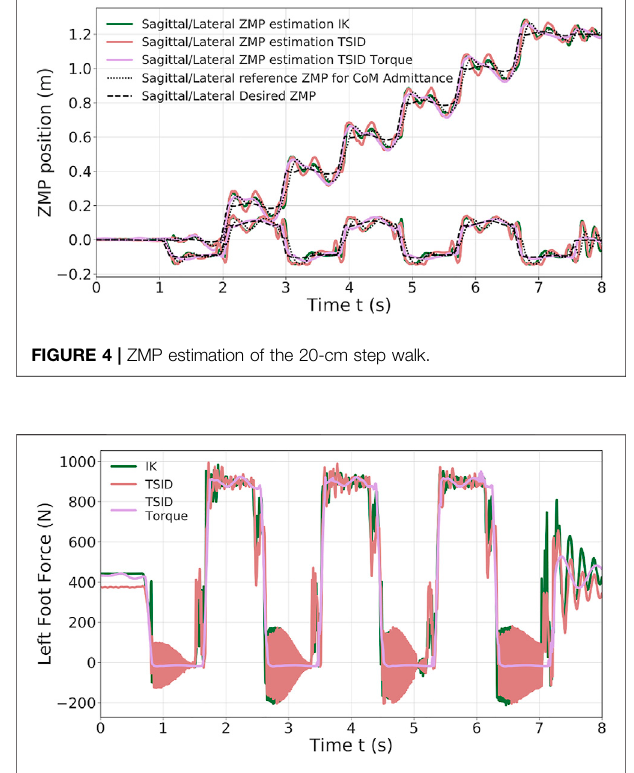
FIGURE 5 | Z-axis left foot force of the 20-cm step walk.